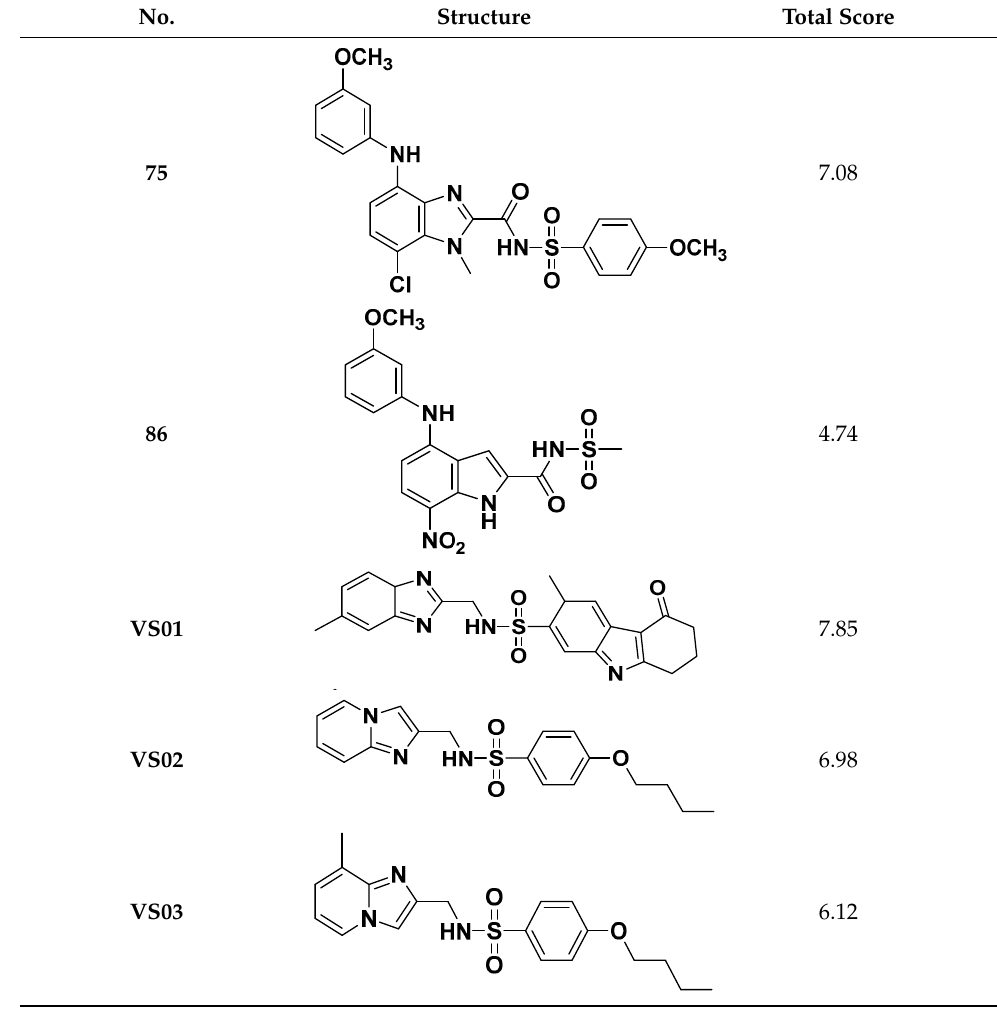
Table 4. Chemical structures and docking scores of compounds 75 , 86 , and the screened hits ( VS01 , VS02 , and VS03 ).